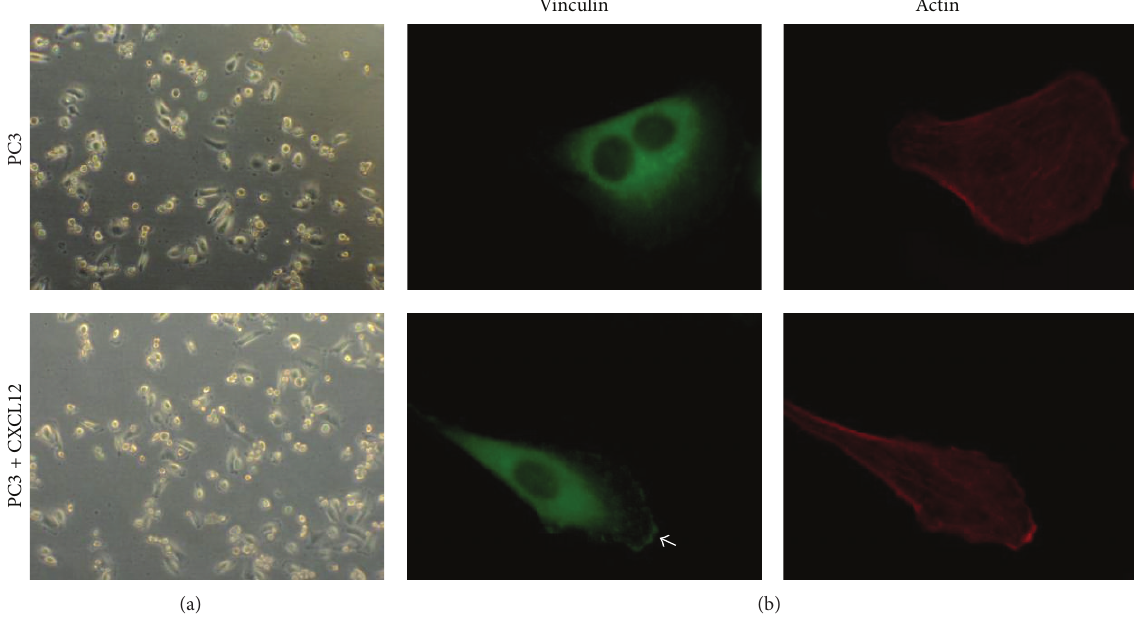
Figure 4: CXCL12 induces focal adhesion formation, actin stress fiber rearrangement, and morphological change in PC3 cells seeded on FN. Cells were incubated for 2 hrs, fixed, and double-stained for vinculin and actin. Arrows in the images indicate localization of vinculin at the end of actin bundles in focal adhesion